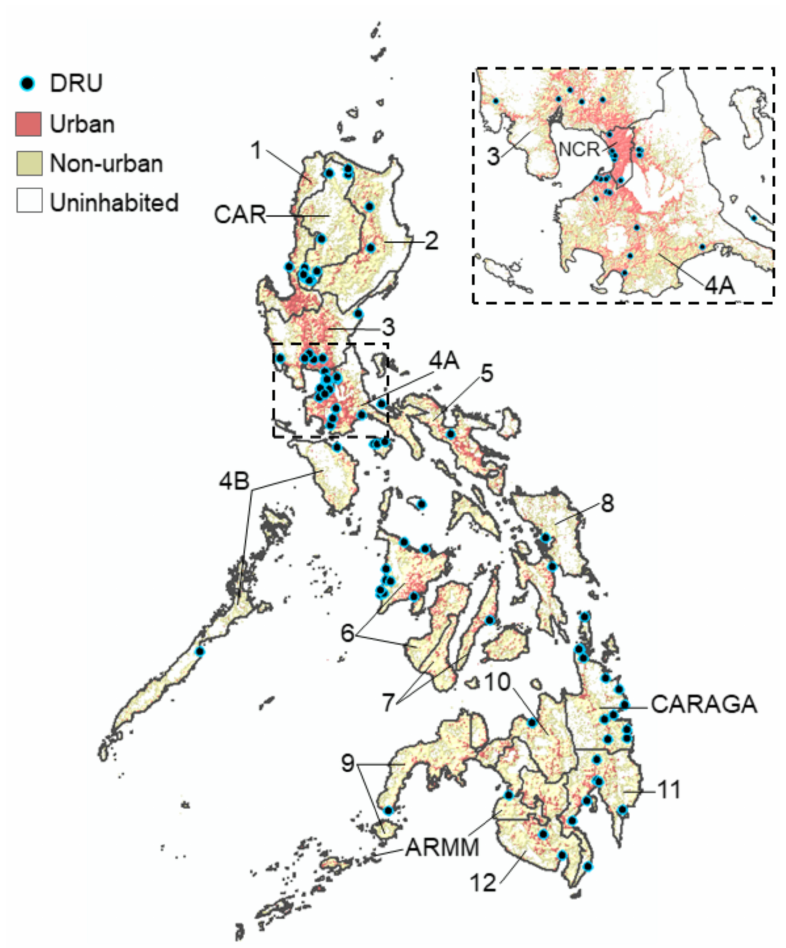
Figure 1. Map of the Philippines showing the location of the 102 DRUs where dengue patients were sampled from across all 17 regions during 2016. Urban zones: >1500 persons per km 2 . Non-urban zones: <1500 persons per km 2